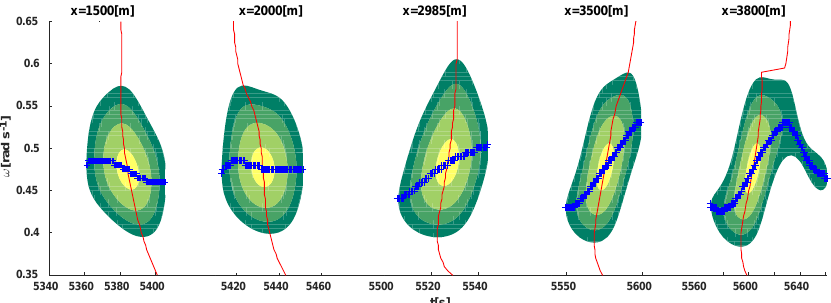
Figure 20. Case TS10000. A filled contour plot of the energy distribution of the critical group event at various positions. At each position, the red solid lines show the time of maximal energy at each wave frequency. The ++ lines show the wave frequency as function of time. Both are estimated by the most energetic waves in time and frequency, respectively.